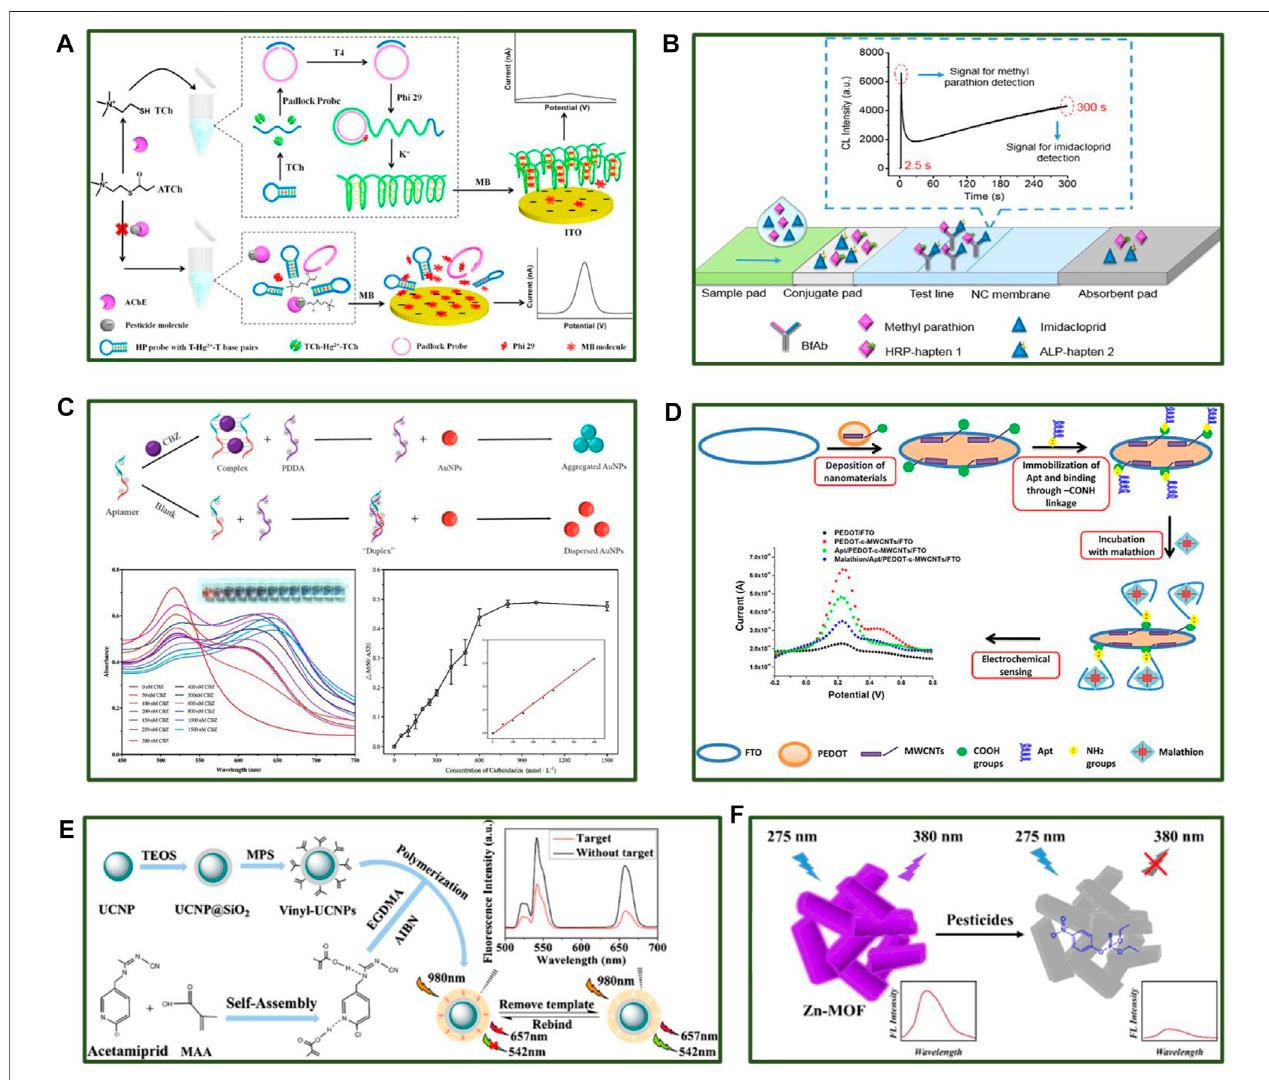
FIGURE 1 | Different applications for the rapid and sensitive detection of pesticide residues based on multiple recognition. (A) Enzyme-based recognition biosensorsforOPsandcarbamatepesticides. (B) Testpaperfordetectingpesticidecompoundsbasedonantibodies. (C) Aschematicofcarbendazim(CBZ)detection using a colorimetric sensor (top), the solution absorbance in different CBZ concentrations (bottom left), the detection performance of the colorimetric sensor (bottom right). (D) A schematic of malathion detection using an electrochemical sensor. (E) The construction of molecularly imprinted upconversion nanoparticles and the detection process. (F) The application of Zn-MOF for parathion